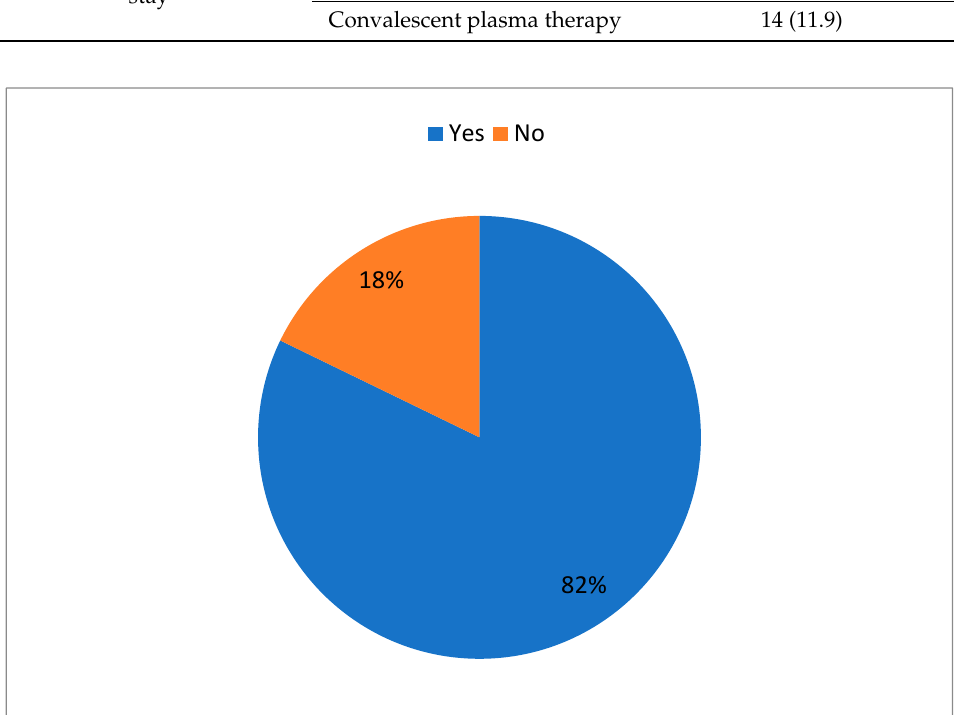
Figure 1. Distribution of post-COVID patients with at least one persistent/new symptom over two weeks after acute COVID-19 infection (N-118).